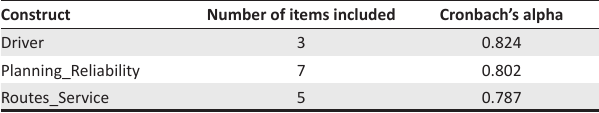
TABLE 9: Internal reliability (final model).